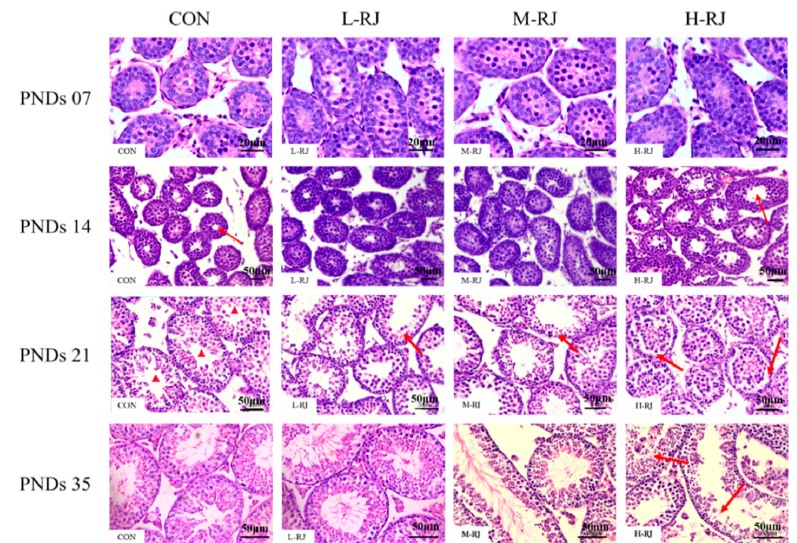
Figure 4. Effects of different doses of freeze-dried RJ on the histoarchitecture of seminiferous tubules at Post-Natal Days (PNDs 07, PNDs 14, PNDs 21 and PNDs 35) in mice. The images pasted with letter “CON” represent mice in control group, showing the normal features, the images pasted with letter “L-RJ”, ”M-RJ” and ”H-RJ” represent low dose of freeze-dried royal jelly treatment group, moderate dose of freeze-dried royal jelly treatment group and high dose of freeze-dried royal jelly treatment group, respectively. For each group and each stage, we captured three representative images. At PNDs 07, images were captured at the magnification of 40×. Bar 20 μ m. Testis images of PNDs 14, PNDs 21 and PNDs 35 mice captured at the magnification of 20×. Bar 50 μ m. Red arrows in PNDs 14 indicate the space of seminiferous tubules. Red arrows in PNDs 21 (L-RJ, M-RJ) indicate the seminiferous epithelium. Red arrows in PNDs 21 (H-RJ) indicate the abnormal space in the basal part of the seminiferous epithelium. Red arrows in PNDs 35 (H-RJ) indicate the un-synchronously seminiferous epithelium. Different markings inside the images were inserted through Adobe Photoshop CS5. 3.5. Histopathological stages and characteristics of germ cell Images in Figure 5 and Figure 6 were used as a handy reference for recognizing the stages and assessing the development of the testis considering our scoring criteria collectively (Table 1). These micrographs showed the histopathological changes at the phases of seminiferous tubules and diverse stages in the cycle of spermatogenesis (Figure 5. Hematoxylin staining of seminiferous epithelia at stages I–XII.). The arrangement micrographs of Figure 5 were evaluated by light microscopic examination under 20× magnification, presented as some common examples and helped to distinguish different type of germ cells respectively. Micrographs of Figure 6 were evaluated under 100× magnification. Special figures and characters were donated according to the staging method defined for laboratory mouse [32,37].